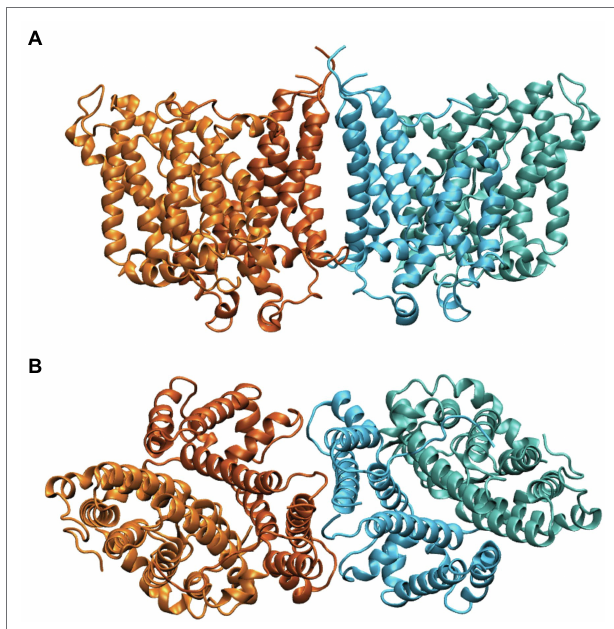
FIGURE 2 | Side (A) and cytoplasmic (B) view of the structure of the dimeric membrane domain of human Band 3 (PDB: 4YZF). The two subunits are shown in orange and cyan. Two shades of orange and cyan show the gate and core domains of each subunit with the gate domains in darker shades at the dimer